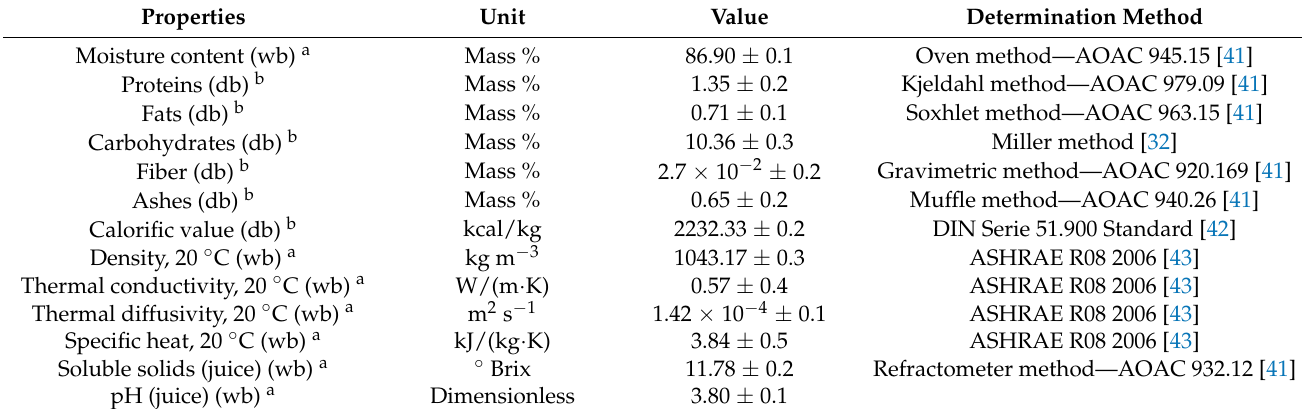
Table 1. Physicochemical characterization of apple pomace obtained.